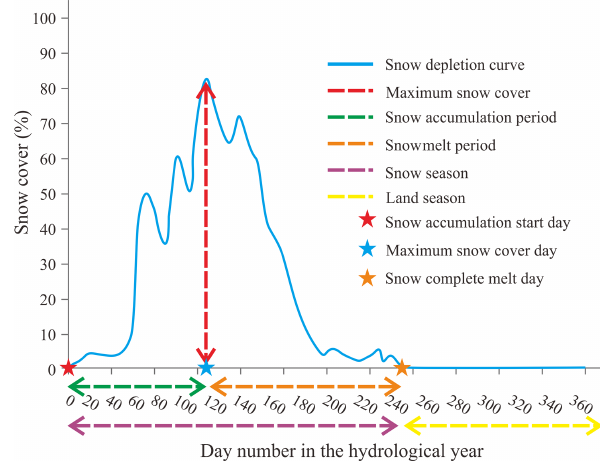
Figure 3. Snow cover depletion curve and the threshold